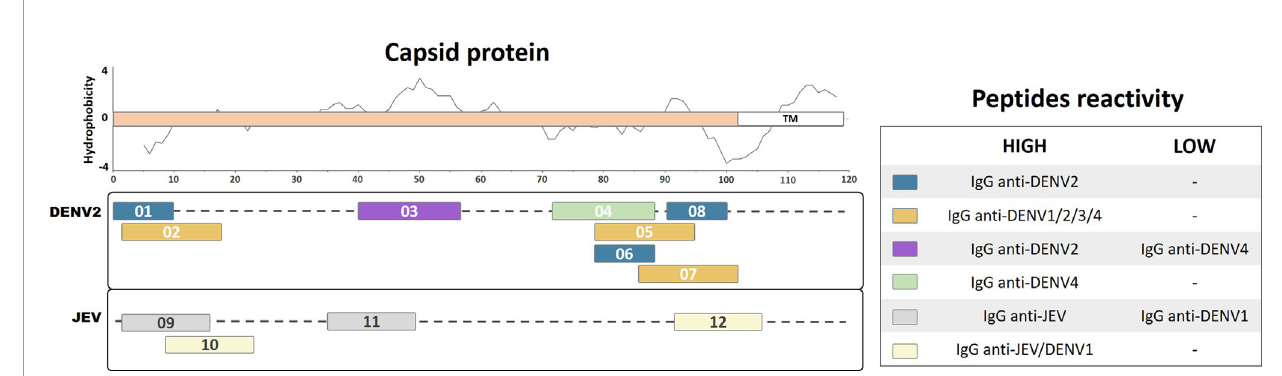
FIGURE 1 | Linear representation of fl avivirus capsid protein with representative topology and hydrophobicity prediction determined based on the ZIKV entry query of Uniprot Q32ZE1. Linear peptides are labeled by numbers and the antibody reactivity indicated by colors. The hydrophobicity prediction pro fi le was determined using the amino acid sequence of the ZIKV (Genbank YP_002790881) with the Kyte & Doolittle hydropathy score scale (J. Mol. Biol. 157:105-132(1982). TM,